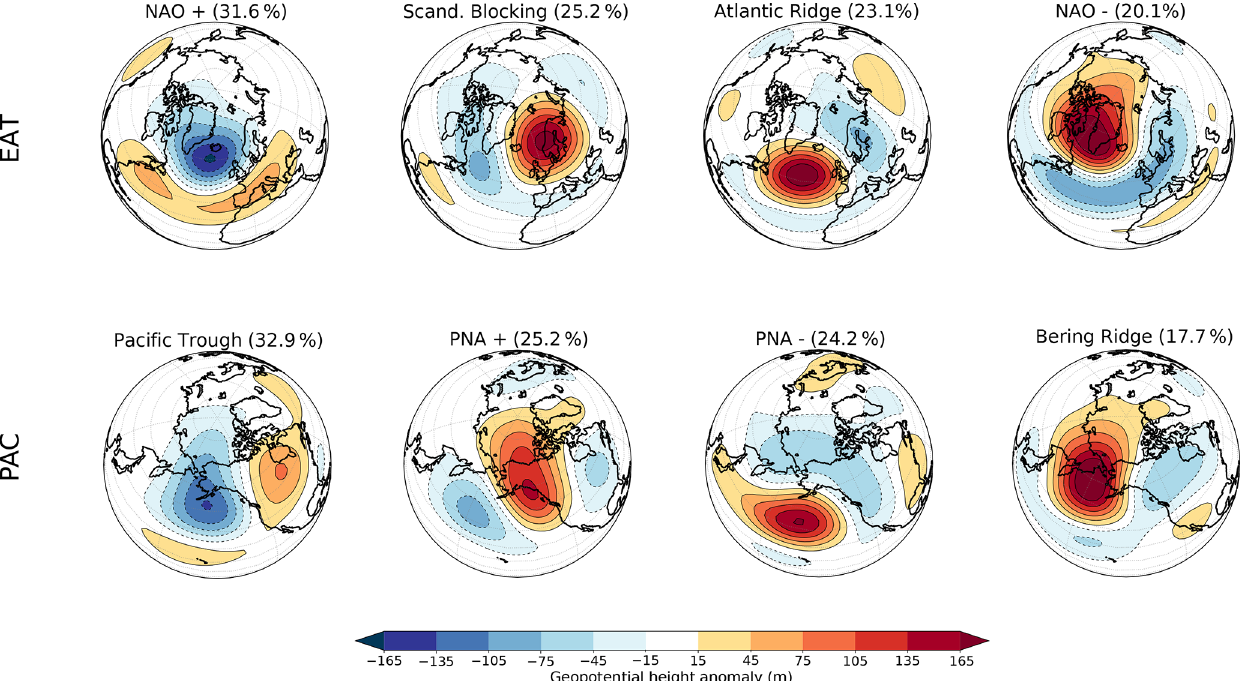
Figure 1. Regime patterns for the Euro–Atlantic (top row panels) and Pacific–North American (bottom row panels) regimes obtained from the reanalysis (1964–2014, NDJFM). The observed regime frequencies are indicated in the subplot titles. Note that the projection is centred on the Atlantic (Pacific) for the EAT (PAC) regime.